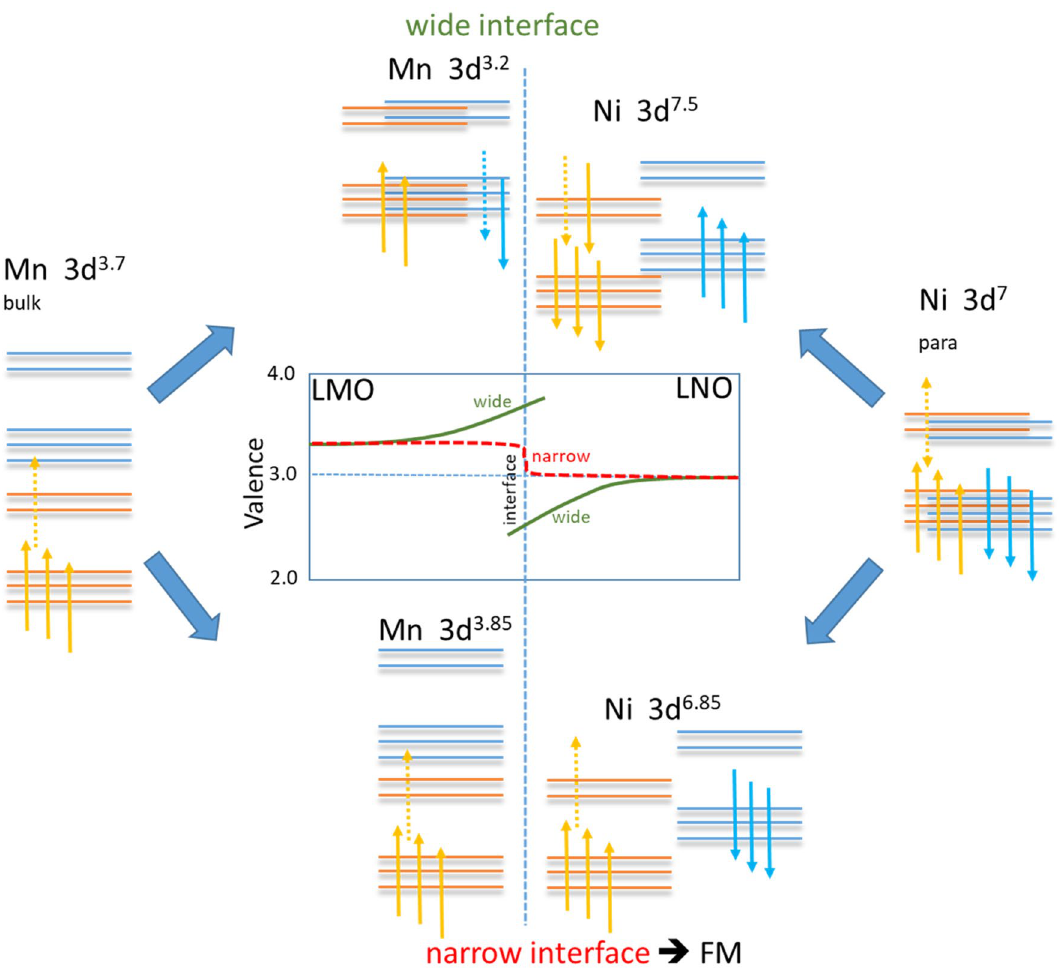
Figure 6. On the left and the right the simplified electronic structure of bulk Mn in LCMO and Ni in LNO are shown. The center part shows the electronic structure of both in contact at the wide and the narrow interface. Dotted arrows represent the configurational averaged non-integer valence, where the 1/3 doping is presented simplified by 3d 3.7 and not as 3d 3.667 . The center graph shows schematically the valence as a function of distance to the interface for the as wide and narrow classified interfaces. For the wide interface valence distributions are extracted from Ref. 2